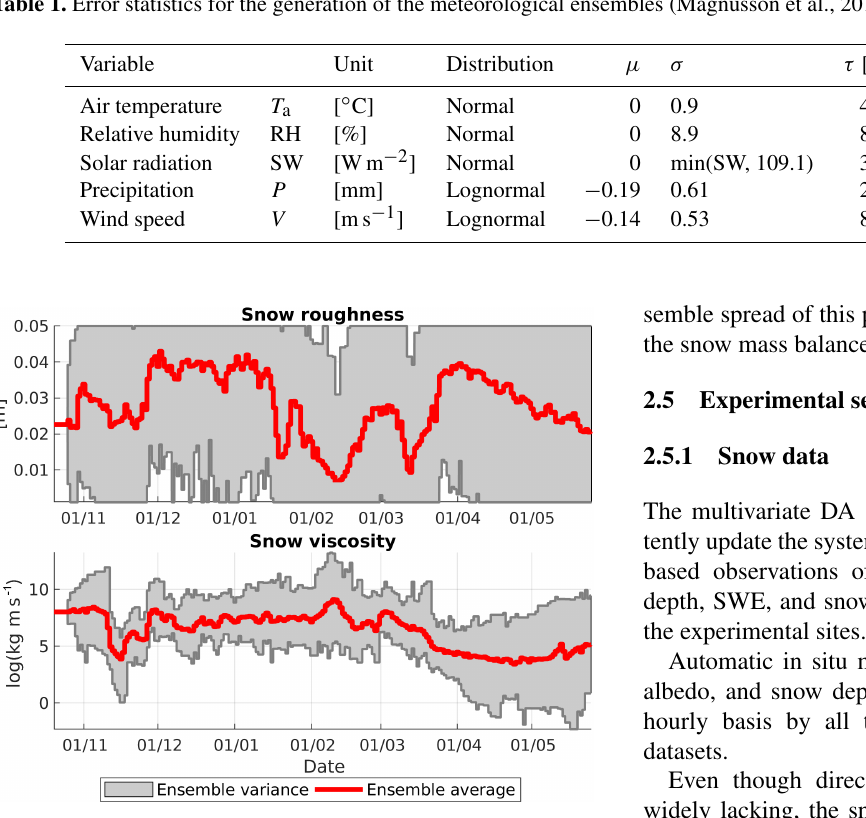
Table 1. Error statistics for the generation of the meteorological ensembles (Magnusson et al., 2017).